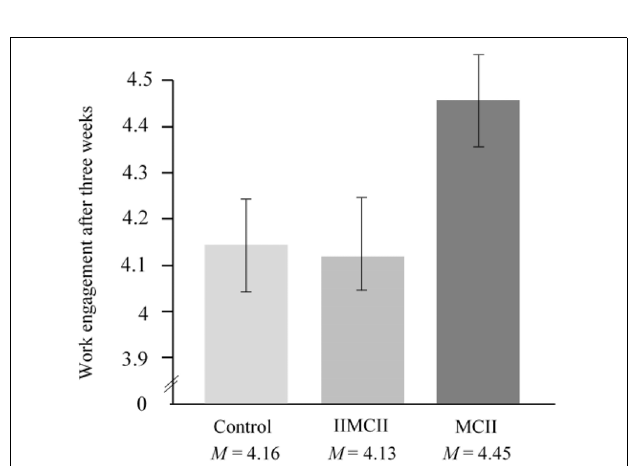
FIGURE 5 | Work engagement after 3 weeks assessed by a questionnaire from Schaufeli et al. (2006) in the three groups of the intervention study, controlling for baseline